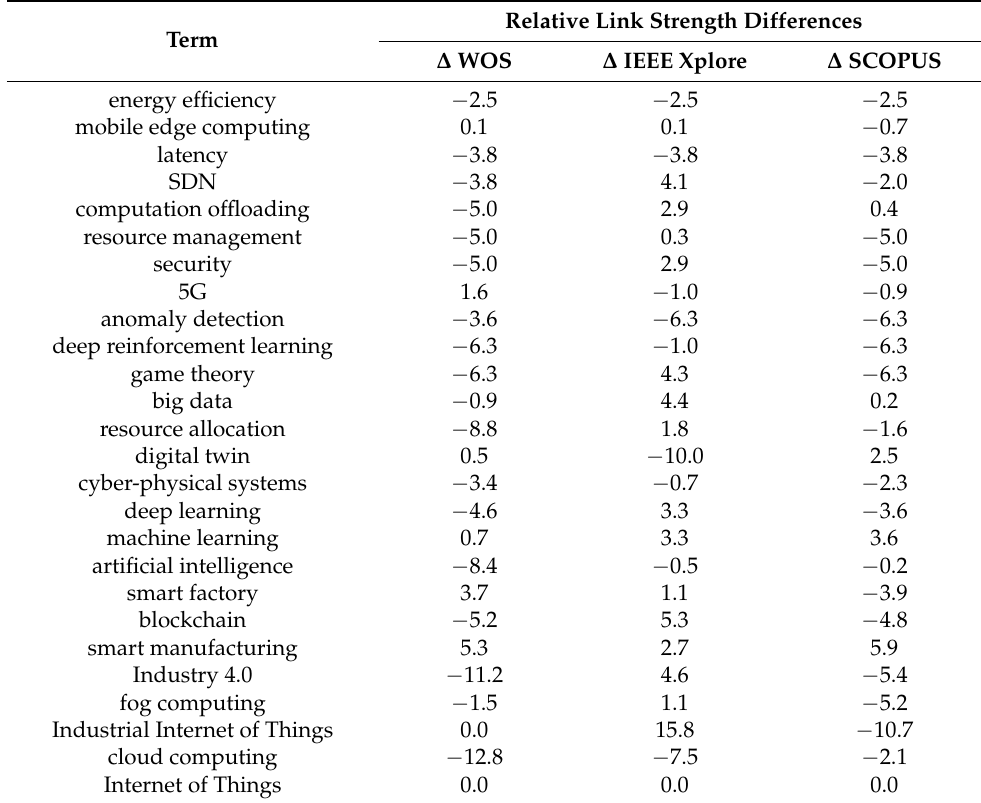
Table 8. Differences in the relative link strength between all data and individual